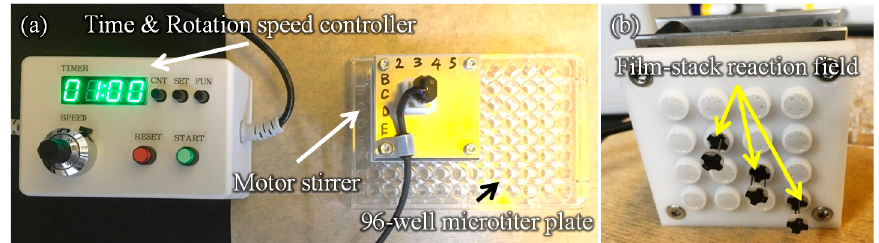
Figure 3. Schematic image of the experimental setup for the ELISA procedure. Figure 3 . Schematic image of the experimental setup for the ELISA procedure. Figure 3 . Schematic image of the experimental setup for the ELISA procedure. Figure 3 . Schematic image of the experimental setup for the ELISA procedure.